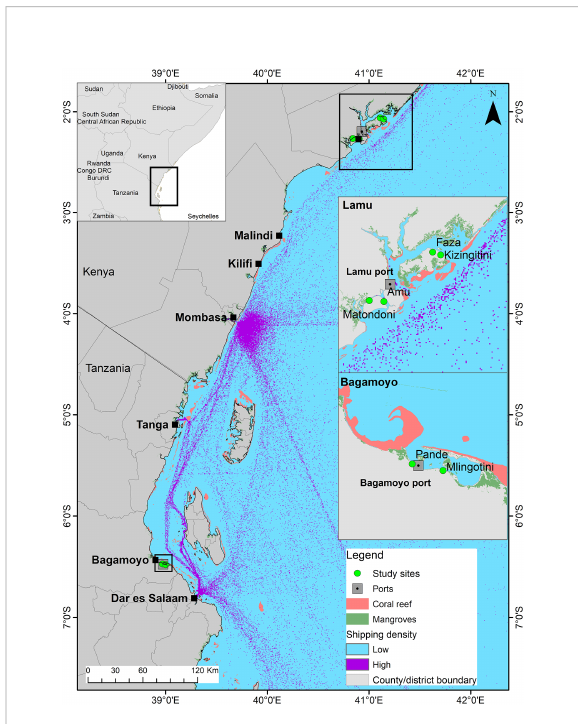
FIGURE 1 The county of Lamu is located north of Mombasa, which is a major port city in Kenya. The Bagamoyo district is located north of Dar es Salaam, which is the capital and a major port city of